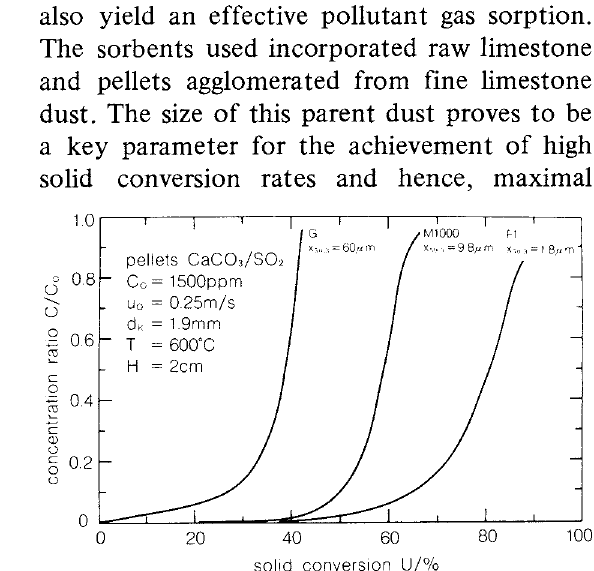
sol1d convers1on U/% Influence of the parent grain size x 50 3 on the Fig. 4 penetration behaviour of so2 for thr~e different limestone pellet beds (pellet size dK = 1.9 mm) at a filter face velocity of u = 0.25 mjs (air 0